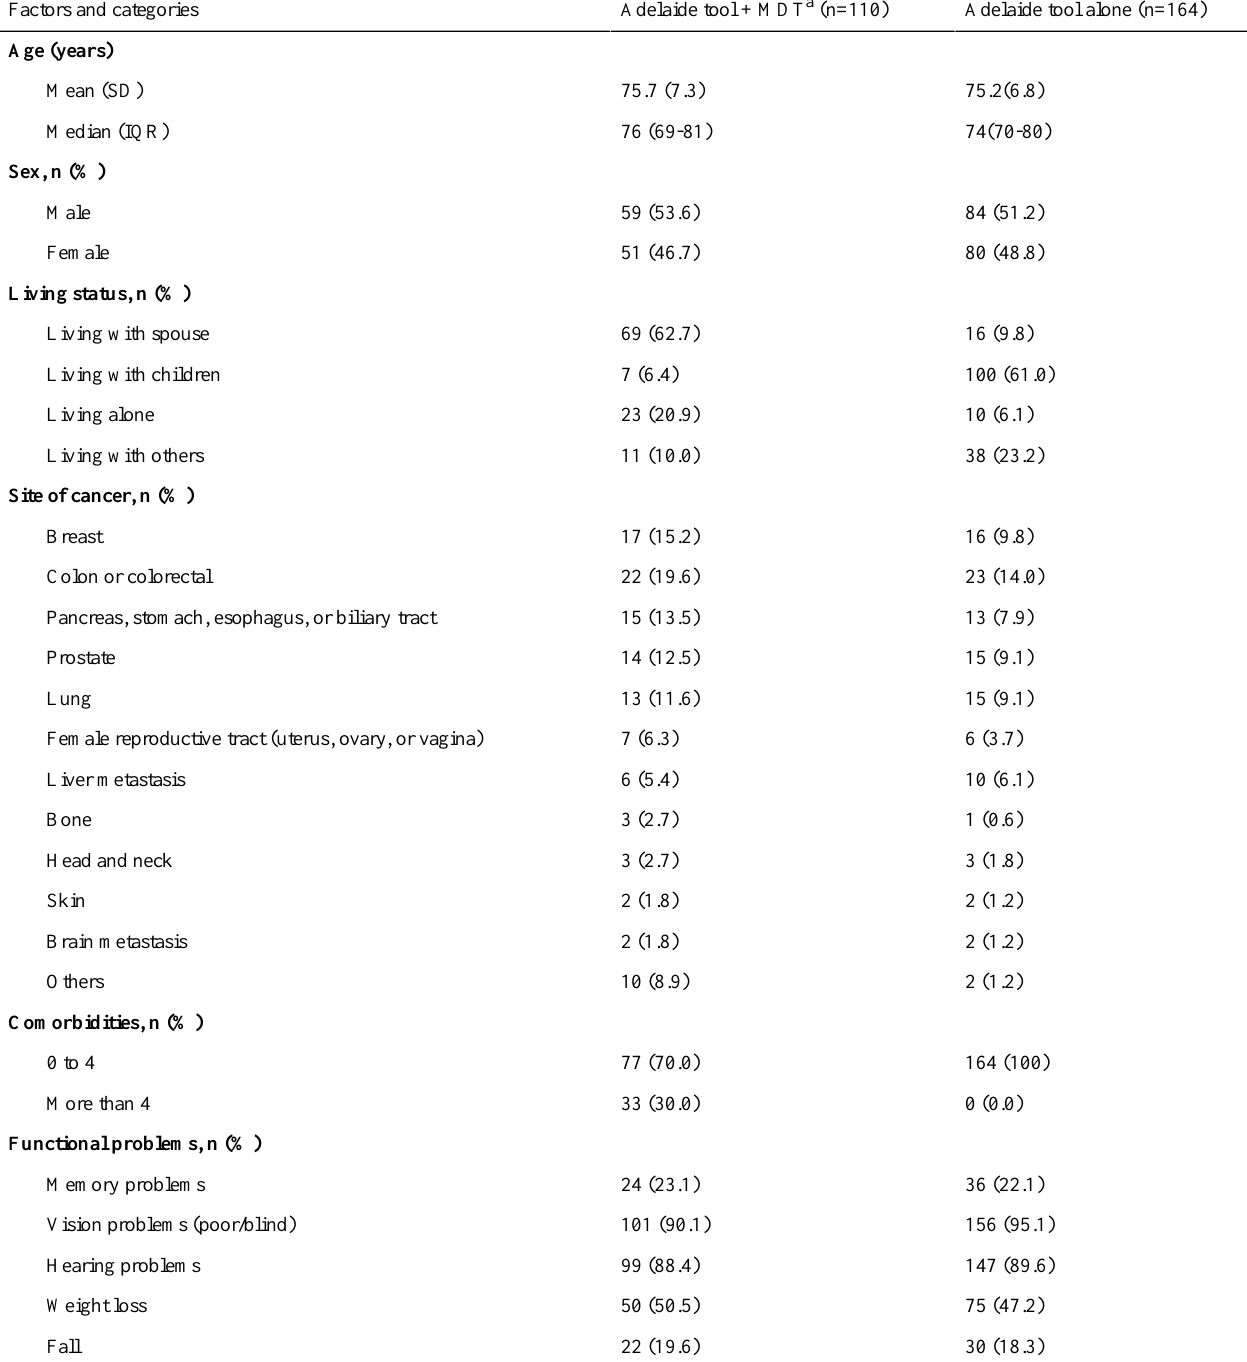
Table 1. Demographic and clinical characteristics of geriatric patients attending a regional cancer care center